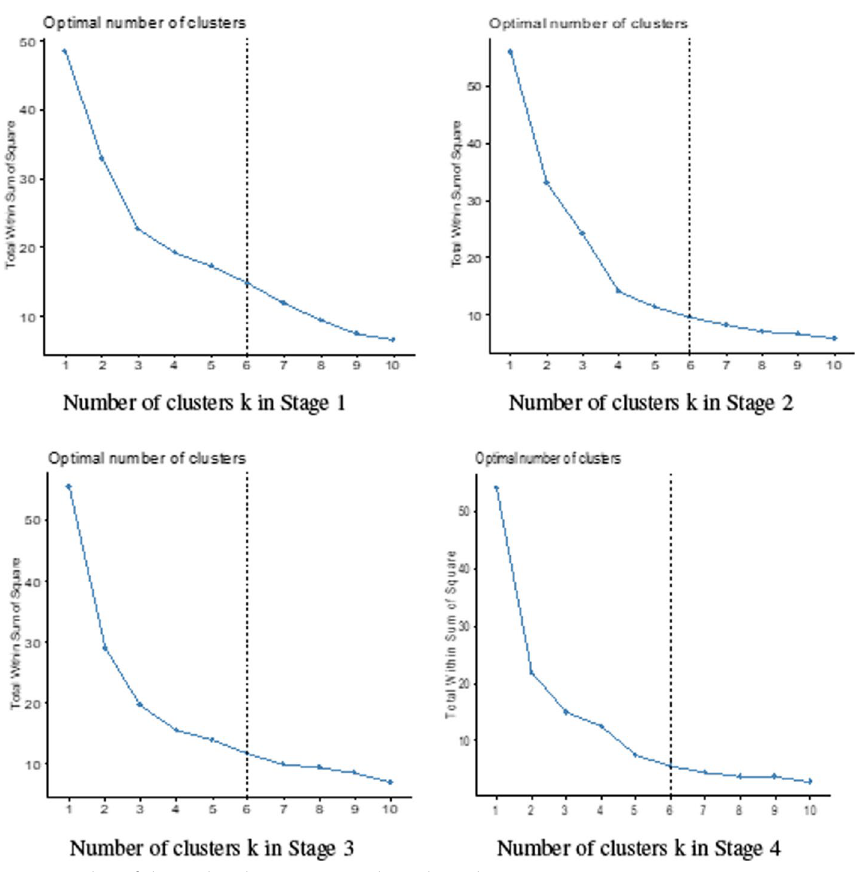
Fig. 1 Number of clusters k with spatiotemporal correlation by stage